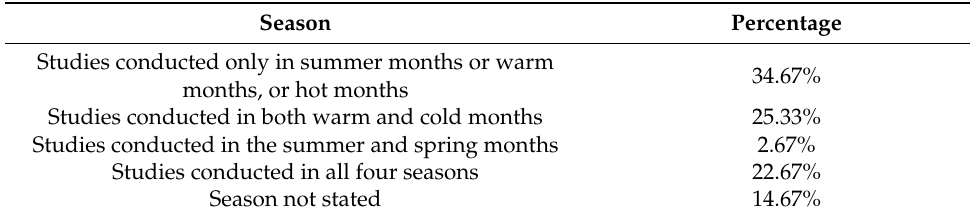
Table 2. Percentage of reviewed articles by